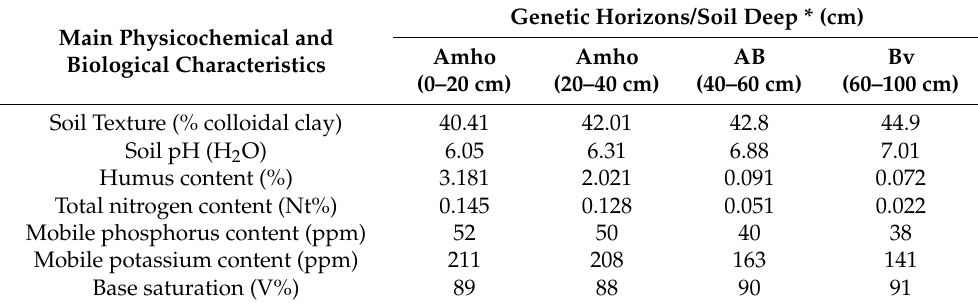
Table 1. The main characteristics of the soil from the orchard of “Vasili Adamachi” experimental farm, Faculty of Horticulture, “Ion Ionescu de la Brad”, Iasi University of Life